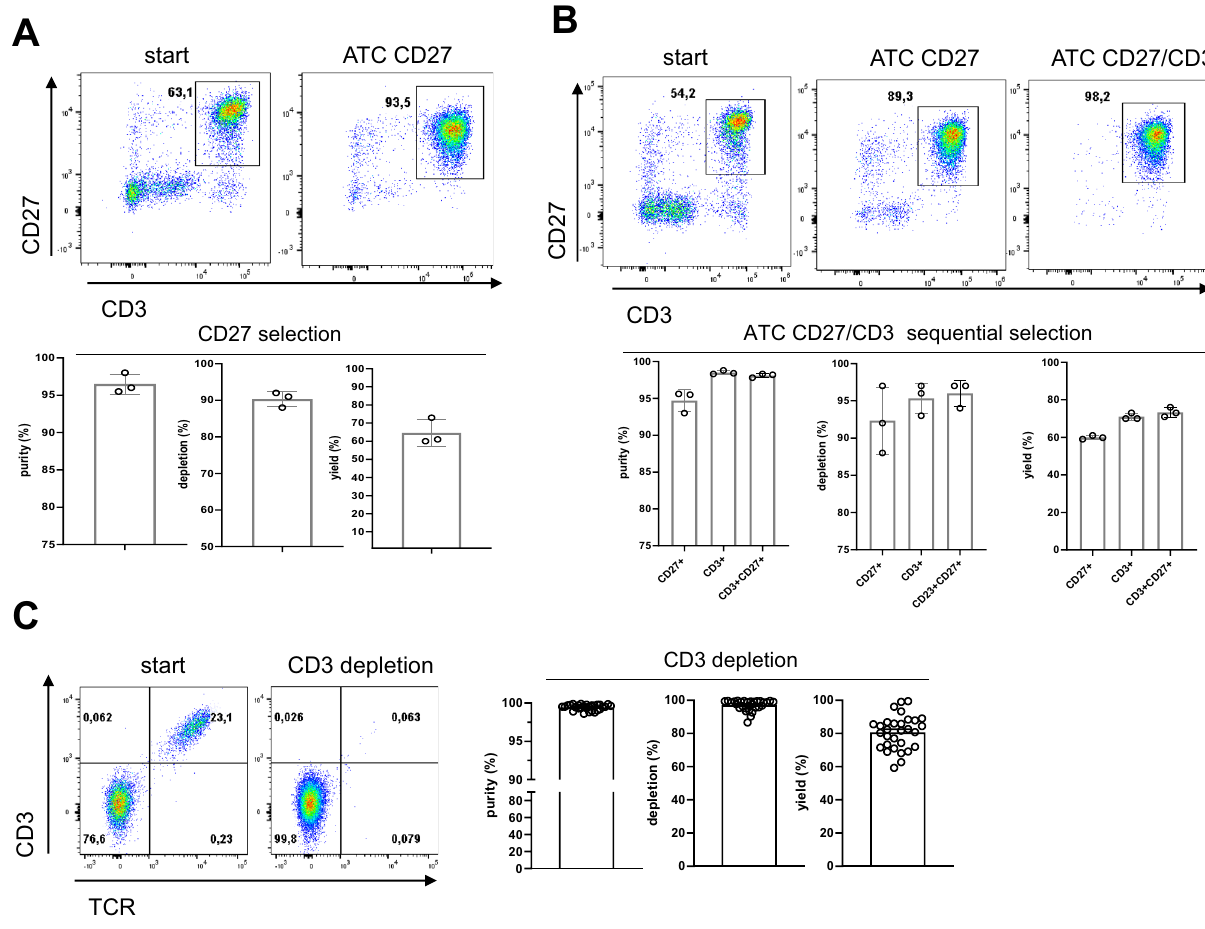
Figure 4. Examples of multiplexed ATC selections for the generation of more homogenous T cell populations. ( A ) ATC CD27 selection efficiently enriches for CD27 + cells. Dot plots of one representative selection are shown. Graphs display purity, depletion, and yield based on the frequency of CD27 + cells. Cells were pre- gated on live, single CD45 + lymphocytes. Graph summarizes data from 4 independent measurements. Bars represent mean ± SD. ( B ) ATC CD27/CD3 selection isolated highly pure CD3 + CD27 + T cells. Dot plots of one representative selection are shown. Graph shows purity, depletion, and yield of either ATC CD27, ATC CD3 or ATC CD27/CD3 selections. Cells were pre-gated on live, single CD45 + lymphocytes. Graph summarizes data from 3 independent measurements. Bars represent mean ± SD. ( C ) ATC CD3 selection can be utilized to remove CD3 + non-edited cells from allogenic T cell product. ATC CD4/CD8 pre-selected T cells were stimulated with Expamers and after 48 h gene edited to knock-out TCR/CD3 expression. Upon the cell expansion, ATC CD3 depletion was performed. Representative dot plots of the flow cytometry staining are shown. Cells were pre- gated on live, single CD45 + lymphocytes. Graphs summarize data from 30 independent measurements. Bars represent mean ±